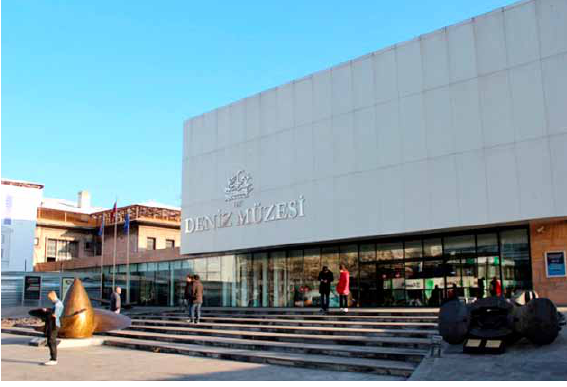
fig. 17. Istanbul naval Museum – entrance (www.arkitera.com)